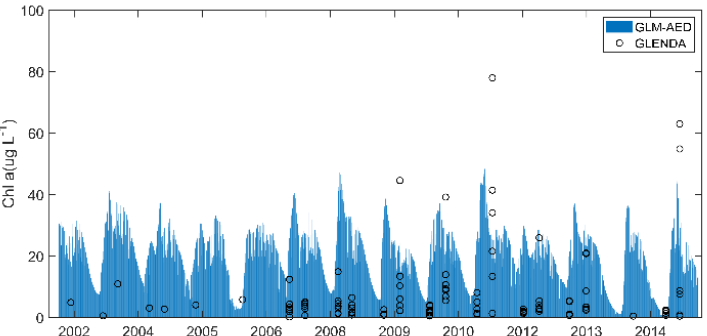
Figure 4. Comparison between depth-averaged simulations and observed total Chl-a from sampling at GLENDA stations for 2002–2015 (ER 58, 59, 60, 61, 91, 92); The GLENDA data have been converted from biovolume to biomass using the conversions in Reavie et al. (2016).